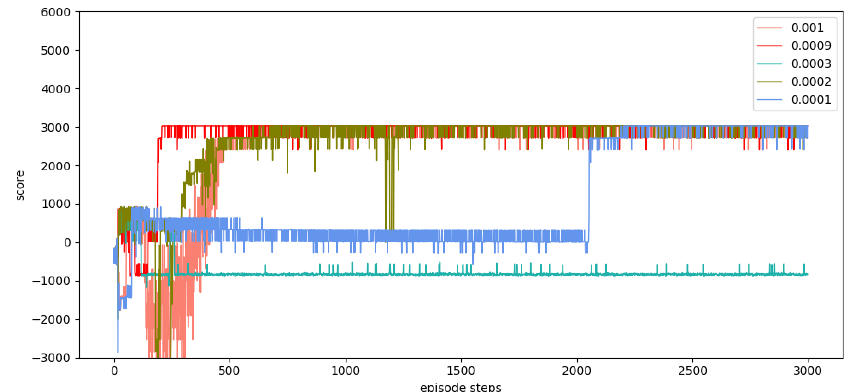
Figure 10. Training result of SD-TD3 (12) algorithm model in environment 2.